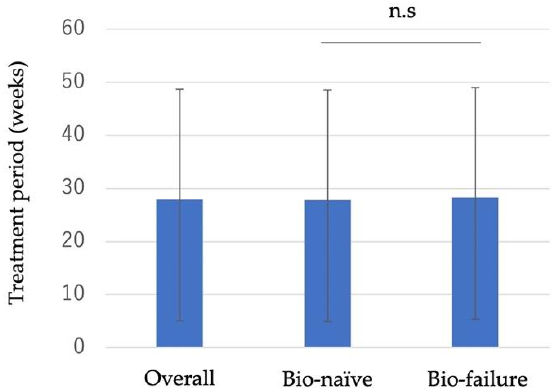
Figure 5. Treatment period in cases where Vedolizumab was discontinued (overall n = 33, bio-naïve n = 13, bio-failure n = 20). Differences between groups were analyzed using Mann–Whitney’s U test. n.s: no significant difference ( p > 0.05).